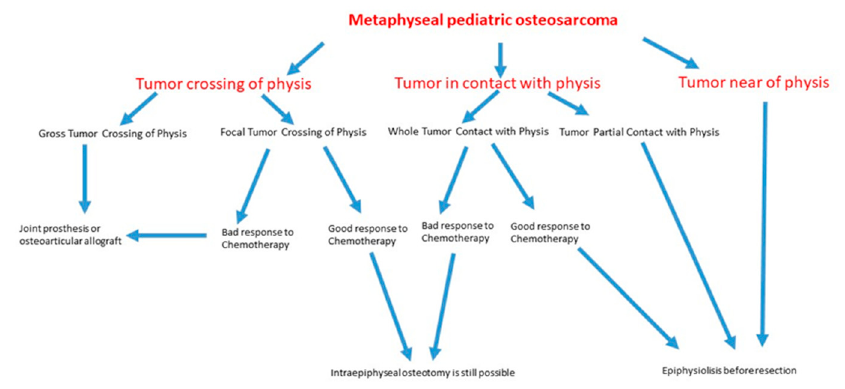
Figure 1. Flow chart that represents stepwise procedures for clinical decision making about the evaluation and management of metaphyseal pediatric osteosarcoma.